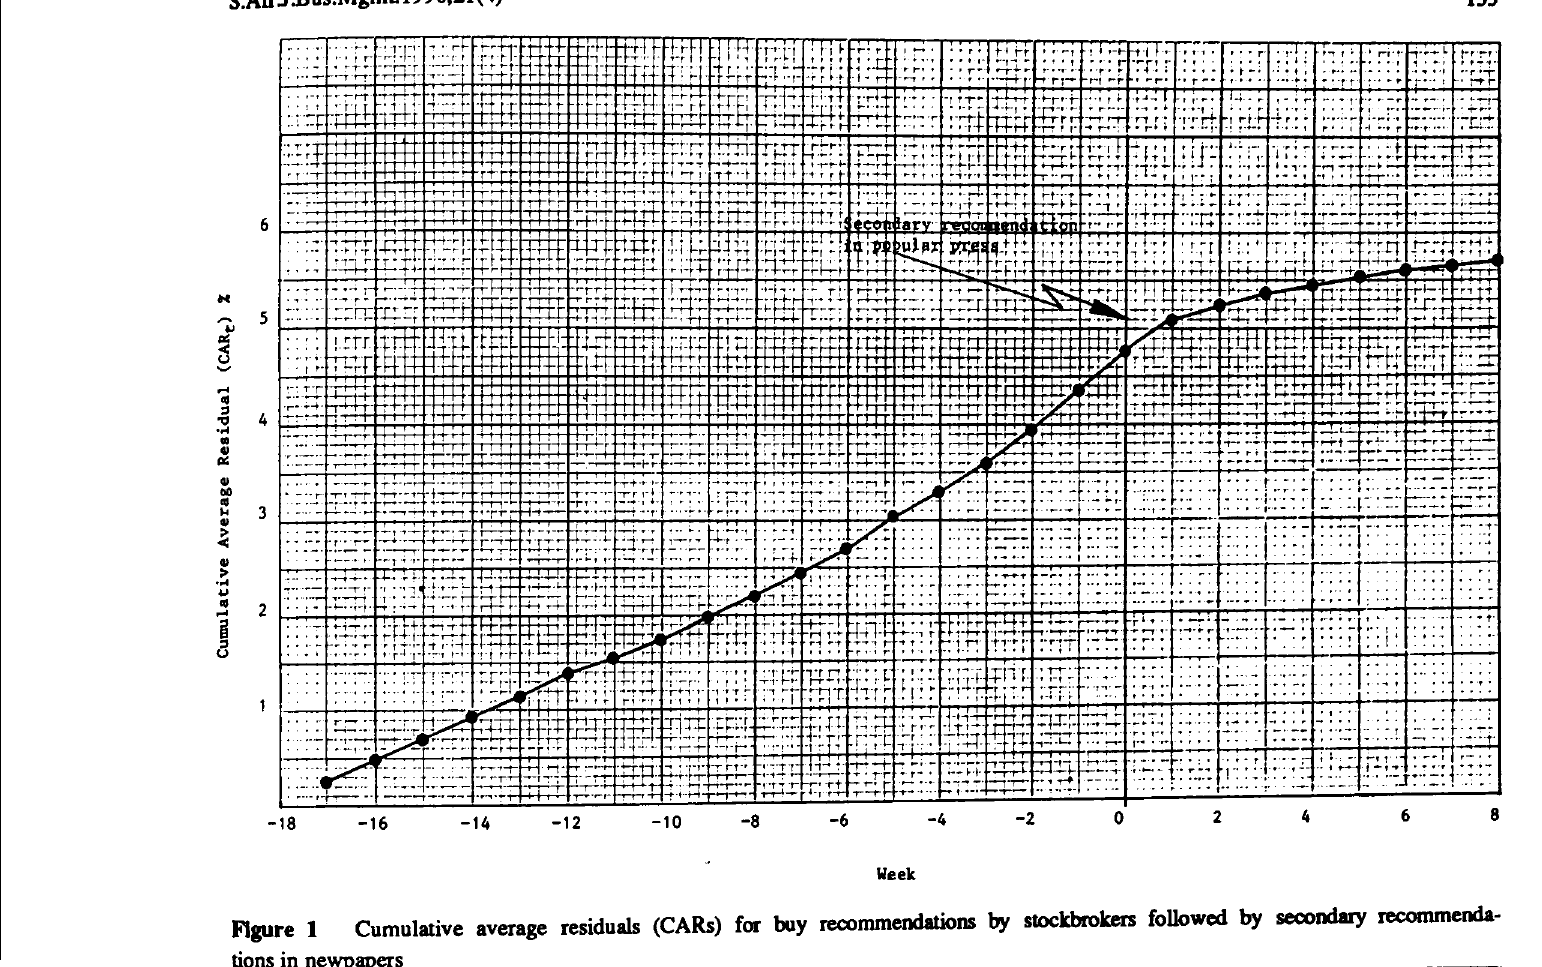
Figure 1 Cumulative average residuals (CARs) for buy recommendations by stockbrokers followed by seconduy recommenda- tions in newpapers